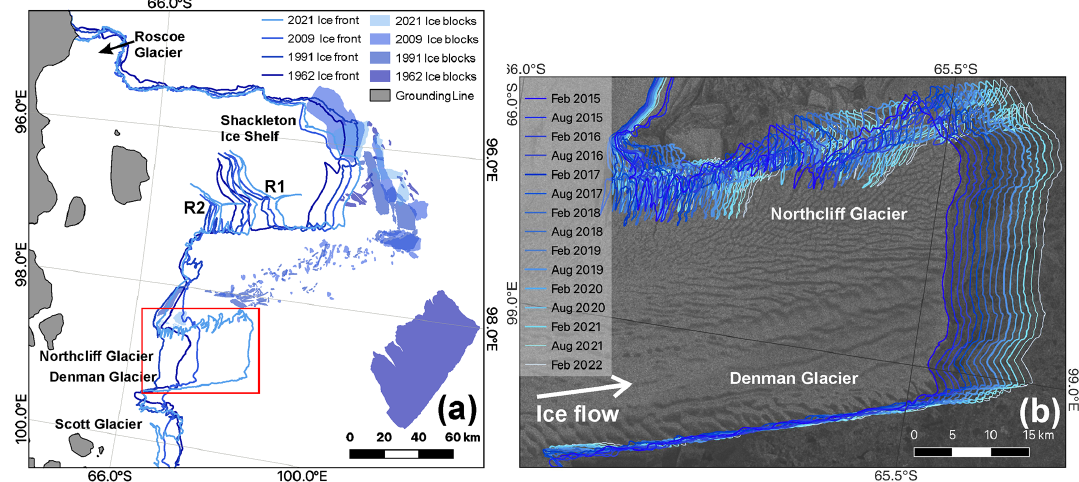
Figure 2. (a) Ice front positions of the Queen Mary and Knox coasts since 1962, including the large iceberg hypothesised to have calved from the Denman tongue in the 1940s. Position and blocks mapped on 16 May 1962 – ARGON KH-5, 10–12 February 1991 – Landsat 5 TM, 1 November–28 February 2009 – Modis MOA (Scambos et al., 2007), and 5–27 February 2021 – Sentinel 2A and 2B. The two main rift systems on the Shackleton Ice Shelf are labelled 1 and 2. (b) Denman Glacier biannual ice front position mapped in February and August from 2015 through 2022 (background: Sentinel 1a acquired on 27 February